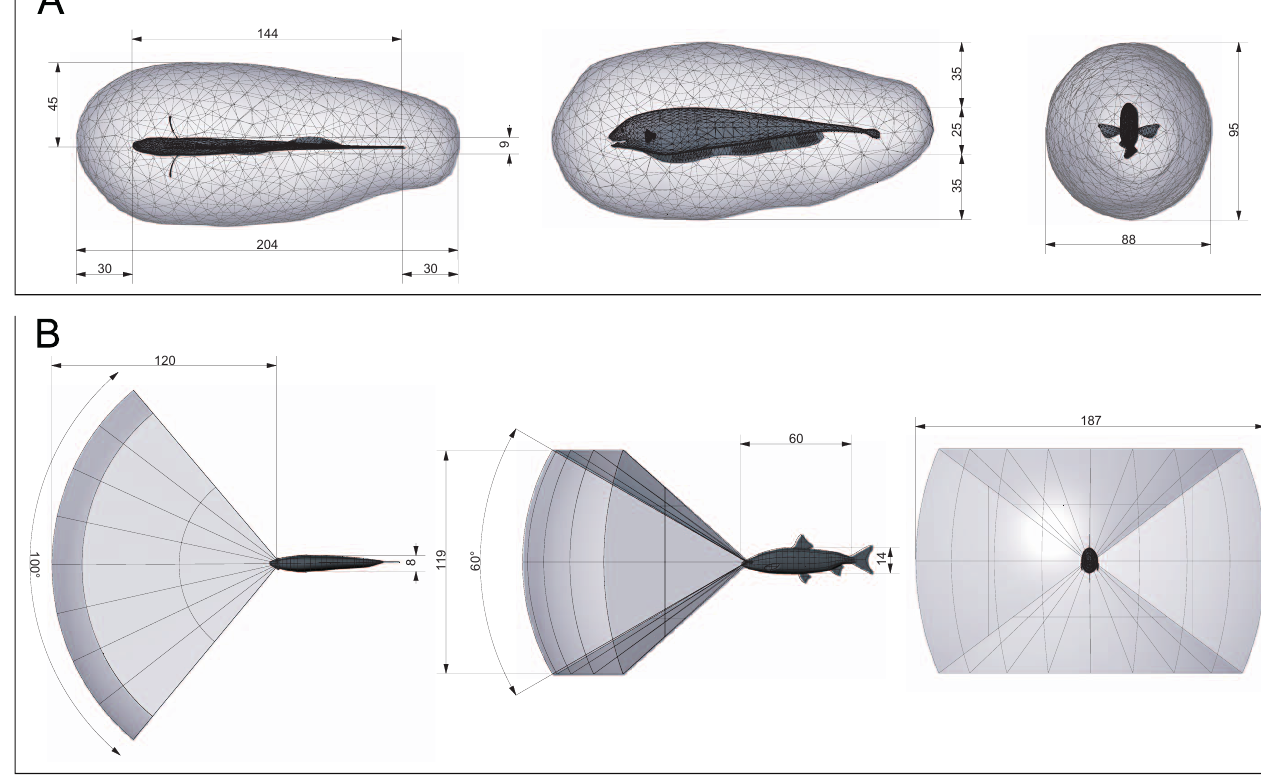
Figure 8. Comparison of Active and Passive Sensory Volumes for Prey Detection in Fish, Dimensions Shown in Millimeters (A) Omnidirectional sensory volume (from Figure 3) for electrosensory prey detection for black ghost knifefish ( A. albifrons , length 144 mm) detecting water fleas ( D. magna , length 2–3 mm). The angular coverage is omnidirectional and the range is 34 mm on average. (B) Forward-directed sensory volume for passive vision, based on prey reaction volumes for stone moroko ( Pseudorasbora parva , length 60 mm) feeding on water fleas ( D. pulex, length 1–2 mm). The angular coverage is approximately 100 8 in azimuth and 60 8 in elevation, with a range that varies from about 60–120 mm, depending on environmental conditions [36]; 120 mm is shown here. The two volumes are similar in size (1,000 cm 3 each) but quite different in shape. Interactive 3-D version is available as Figure